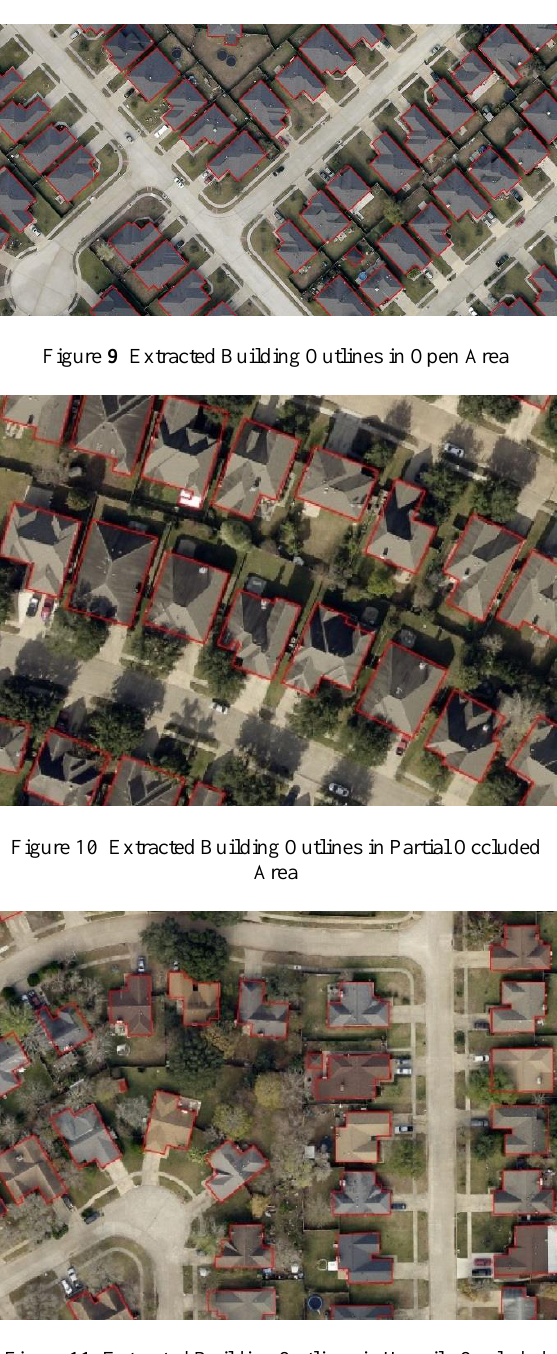
Figure 11 Extracted Building Outlines in Heavily Occluded Area